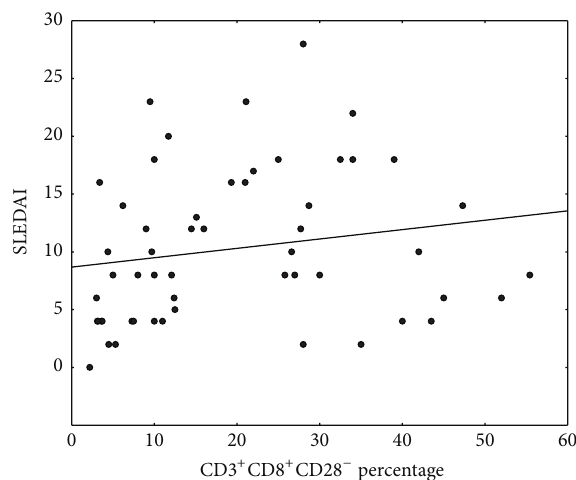
Figure 4: Correlation between the SLEDAI and CD 3 + CD 8 + CD 28 − cells